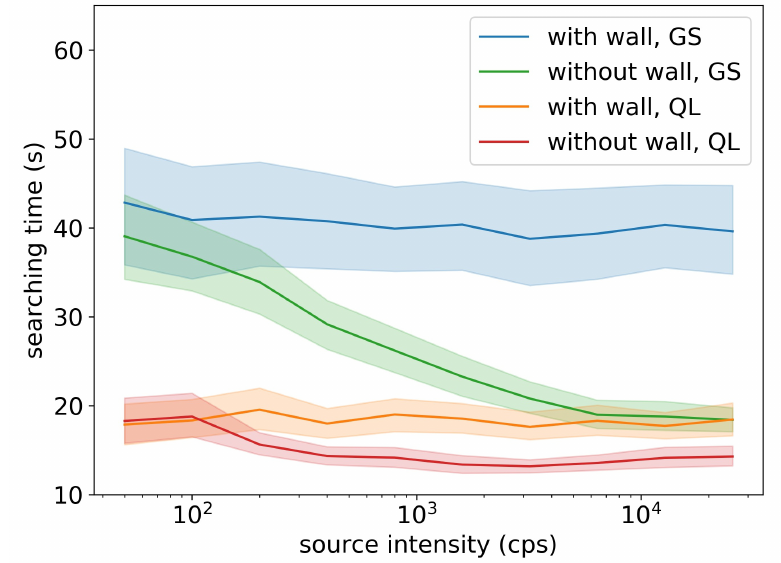
Figure 8. Average searching time under different source intensities. The shaded area is the 95% confidence interval estimated by bootstrapping. The ’GS’ stands for the gradient search method, and the ’QL’ stands for the Q-learning method. The Q-learning method used less searching times than the gradient search method in all simulation